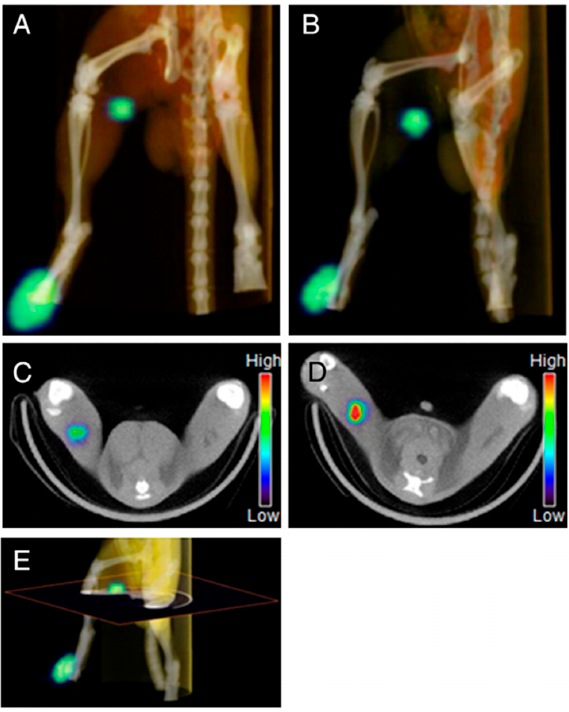
Figure 4. SPECT/CT images ( A – E ) after the injection of 111 In-DTPA-G4/PEI ( A , C ) or 111 In-DTPA- G4/PEI/ γ -PGA ( B , D ) into footpads of SD rats (DTPA-G4: 10 μ g/mL, 1.0–1.7 MBq/ 200 μ L in 5% glucose/rat). Panels ( C , D ) are 2D transaxial images including lymph nodes constructed from 3D images ( A , B ) as shown in ( E ). 111 In-DTPA-G4/PEI/ γ -PGA ( B , D ) clearly visualized the popliteal